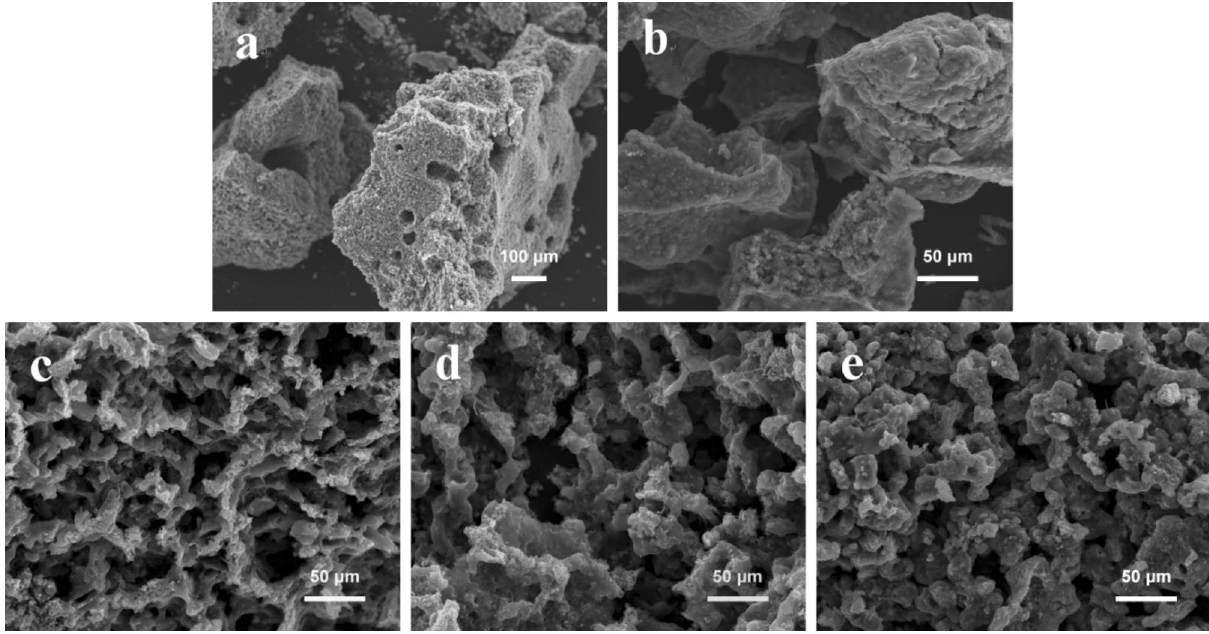
Figure 1. SEM images of ( a ) PC-750, ( b ) PGC-750, ( c ) HPGC-700, ( d ) HPGC-750, and ( e ) HPGC-800. Photographs compiled using Powerpoint 2019 (https:// www. micro soft. com/ zh- cn/ micro soft- 365/ get- start ed- with- office- 2019) without changing the content of images